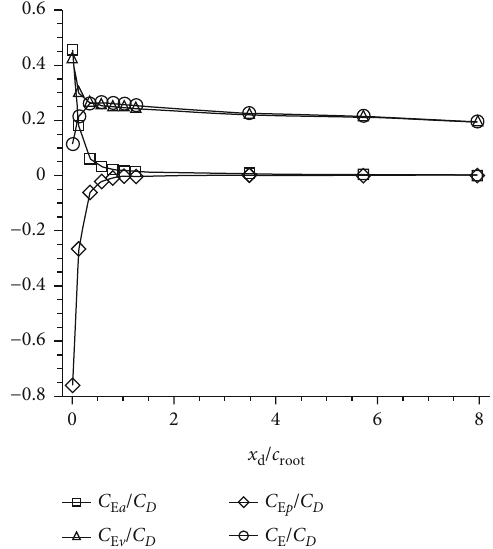
C _ C _ C _ E a , E v , E p , and E to the streamwise